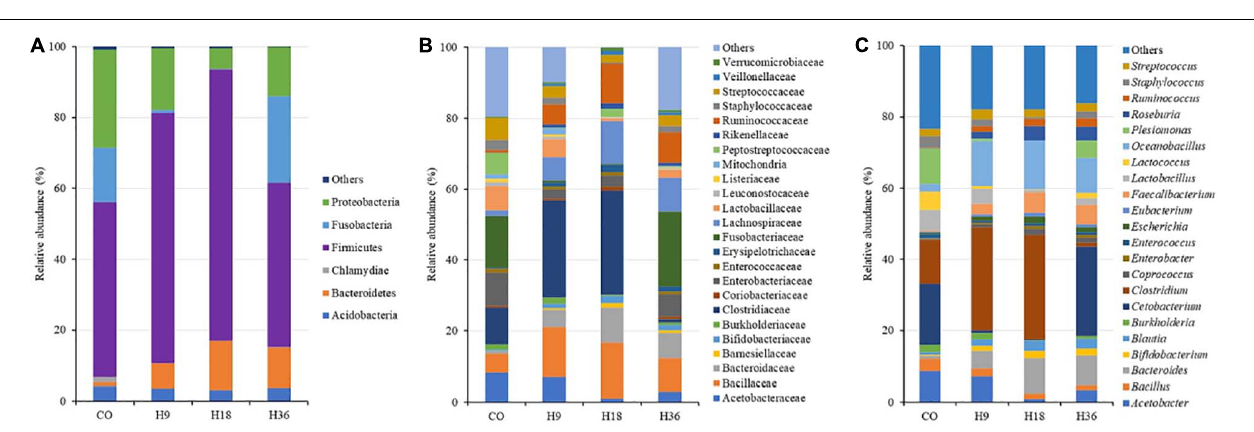
FIGURE 4 | Microbiota composition (PCA plots) in intestine of pikeperch ( Sander lucioperca ) fed experimental diets.